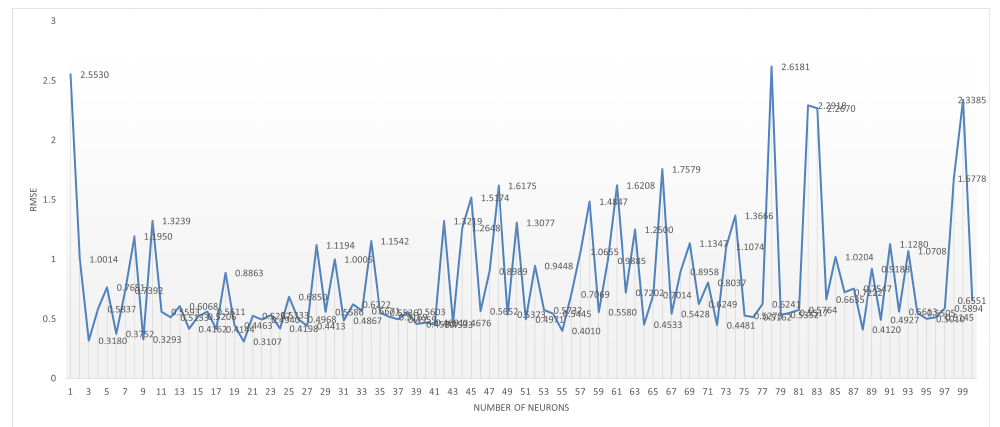
Figure 2. RMSE of ARMA-CNNLSTM forecasts using different model parameters in the validation set of EU ETS financial time series forecasting.